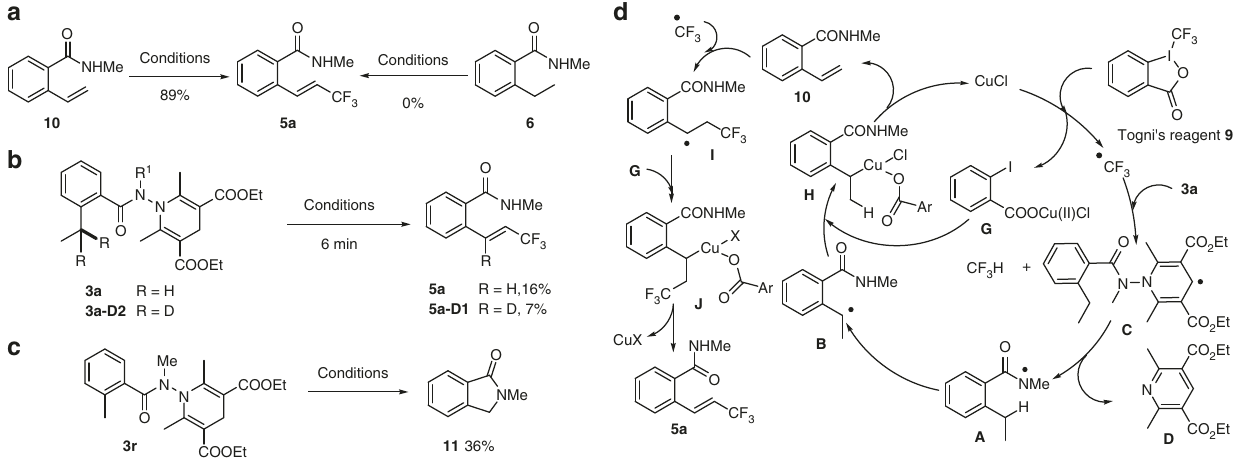
Fig. 5 Mechanistic studies on the oxidative δ -tri fl uoromethylation of 2-alkyl benzohydrazides. a Control experiment; b KIE experiment; c isoindolinone formation; d possible reaction pathway; conditions: 10 or 6 or 3a/3a-D2 (0.1 mmol), Togni ’ s reagent 9 (0.3 mmol), CuCl (0.04 mmol), DCM (1.0 mL, c 0.1